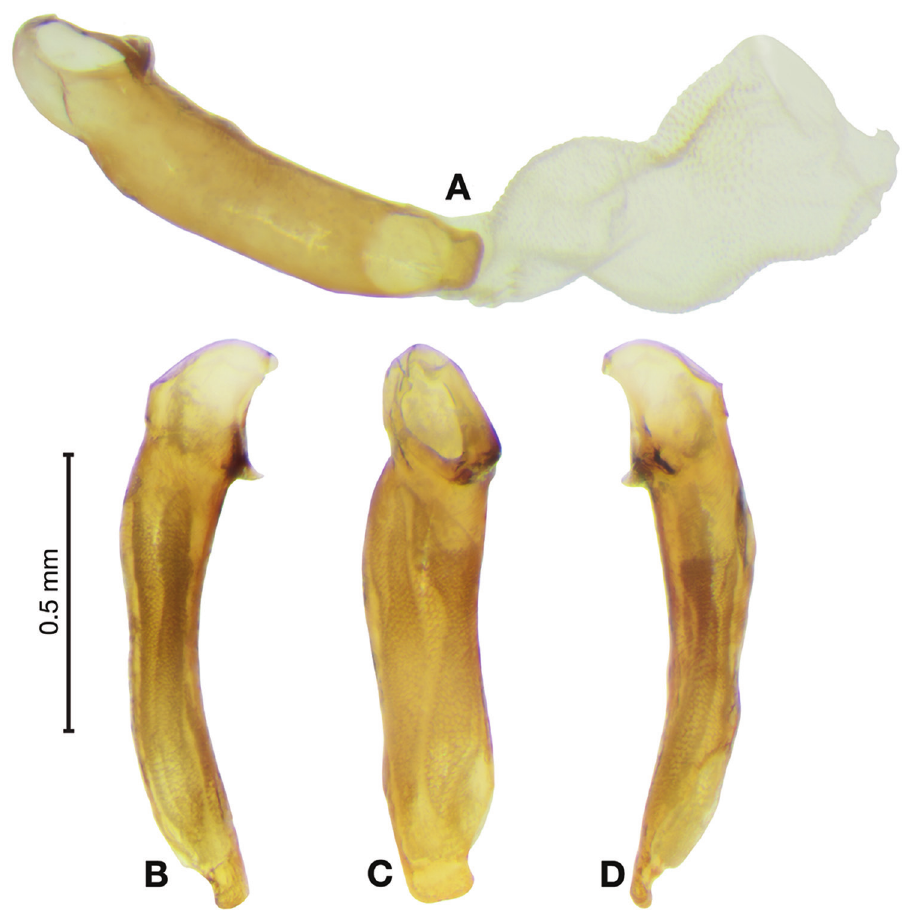
lus everted B right lateral aspect C ventral aspect D left lateral